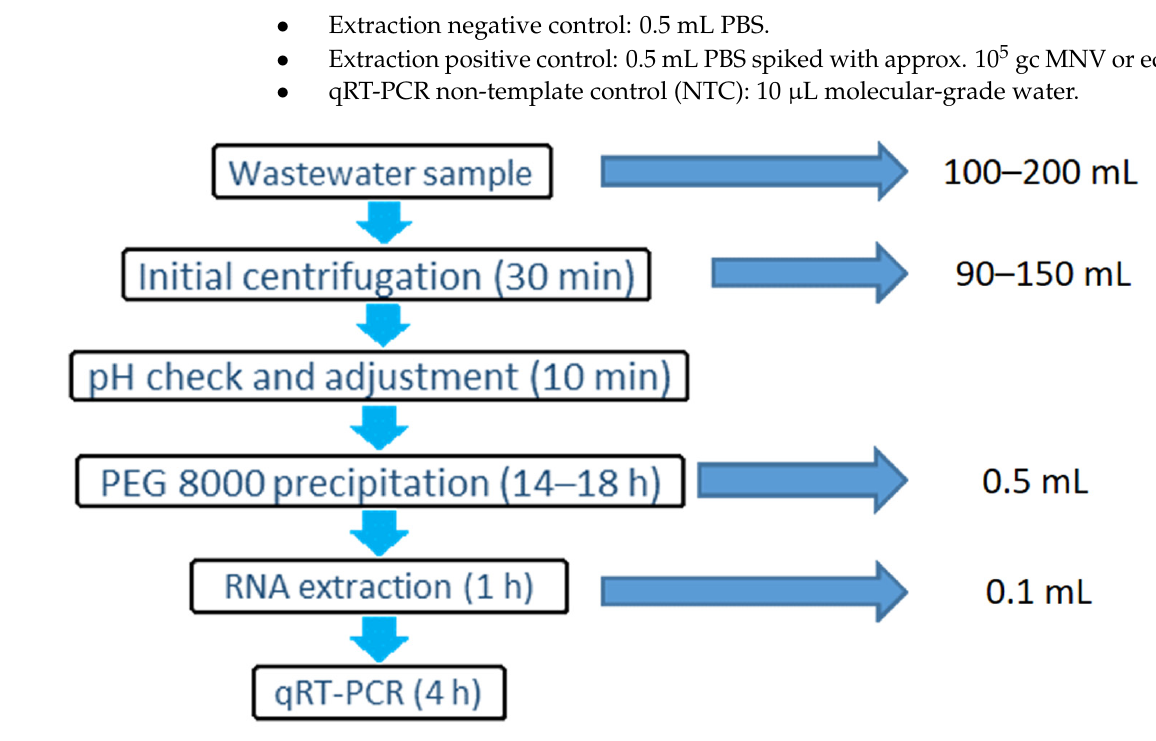
Figure 1. The stages of the wastewater concentration, RNA extraction and quantification method for SARS-CoV-2.